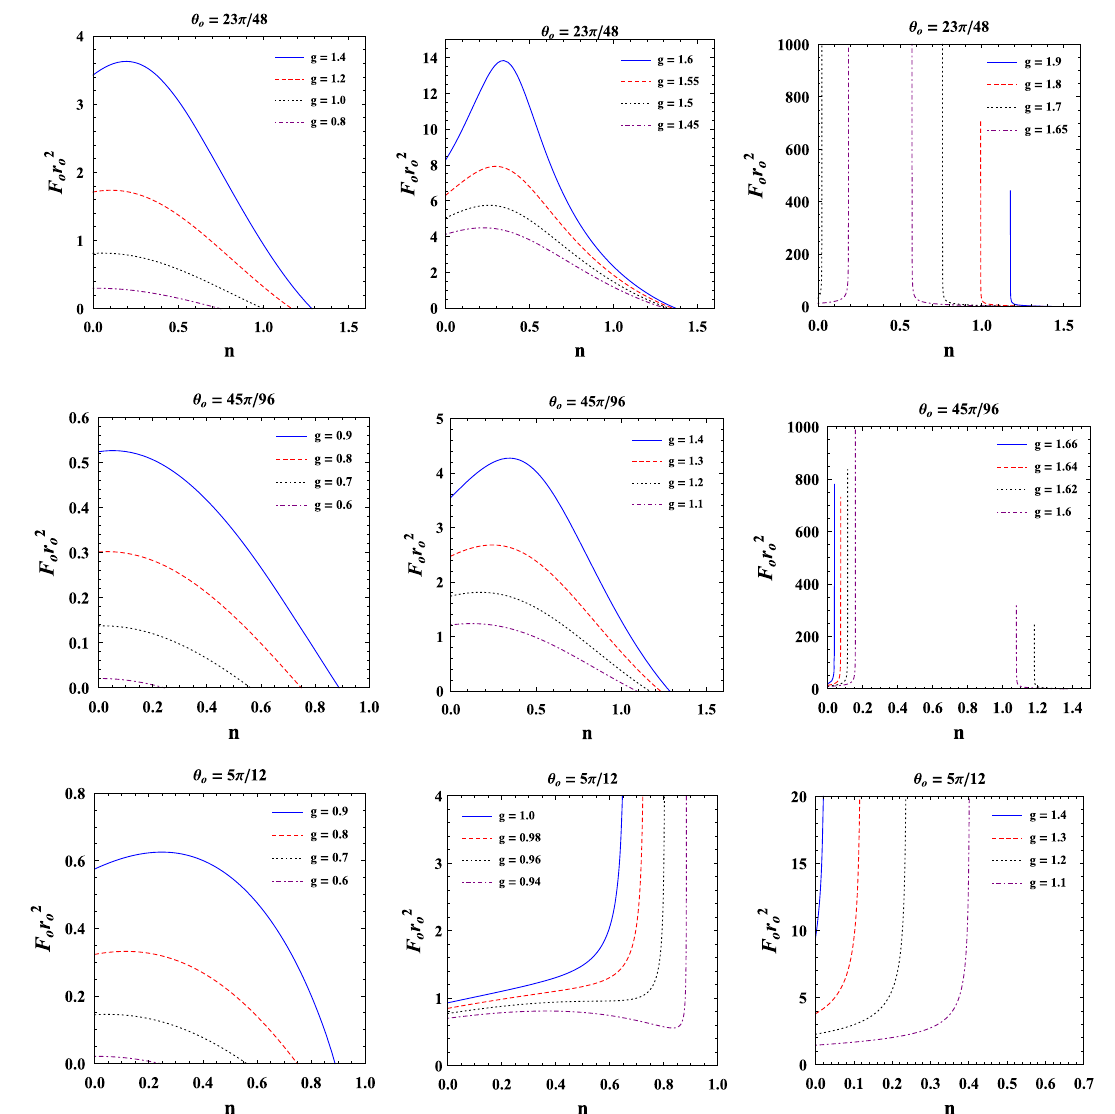
Fig. 7 The change of the flux F o at observer with the NUT charge n for different redshift factor g and the observer’s angular position θ o as the source lies in the NHEKTN line. Here, we set M =